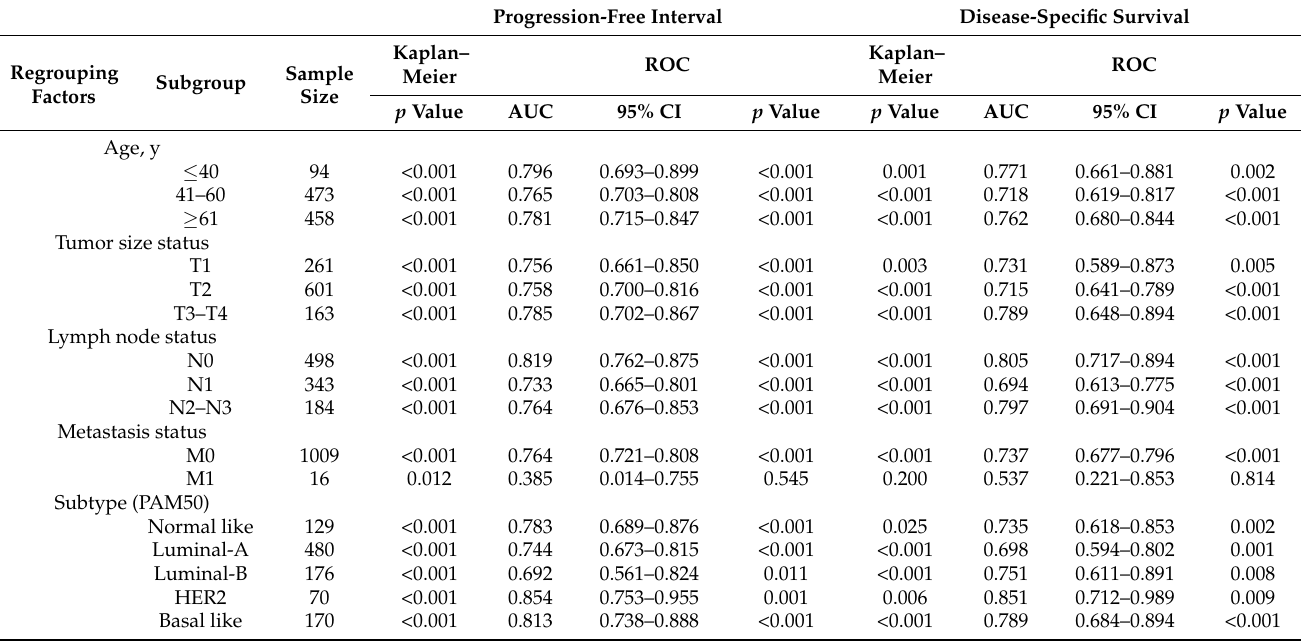
Figure 7. KM and ROC curve analyses of patients stratified by molecular subtype (PAM50). ( A – E , K – O ) KM curves of PFI and DSS for high- and low-risk groups in the normal-like, Luminal A, Luminal B, HER2, Basal-like subgroups. ( F – J , P – T ) ROC analysis showed the sensitivity and specificity of prognostic signature for predicting PFI and DSS for high- and low-risk groups in the normal-like, Luminal A, Luminal B, HER2, Basal-like subgroups. Table 3. Result of Kaplan–Meier and ROC analysis based on different regrouping methods. Progression-Free Interval Disease-Specific